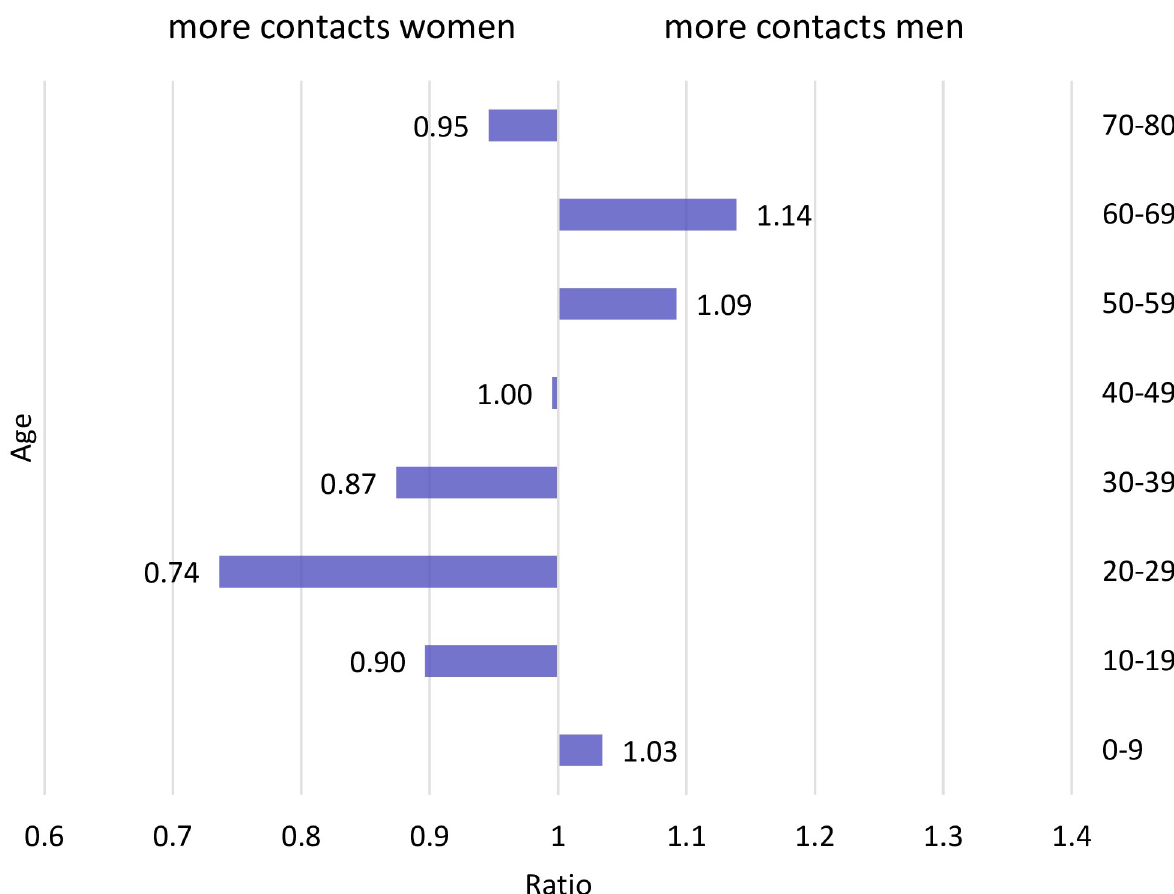
Fig 2. Gender-specific contact rates. Ratio of the average number of contacts among men compared to women, Data Source: [15].